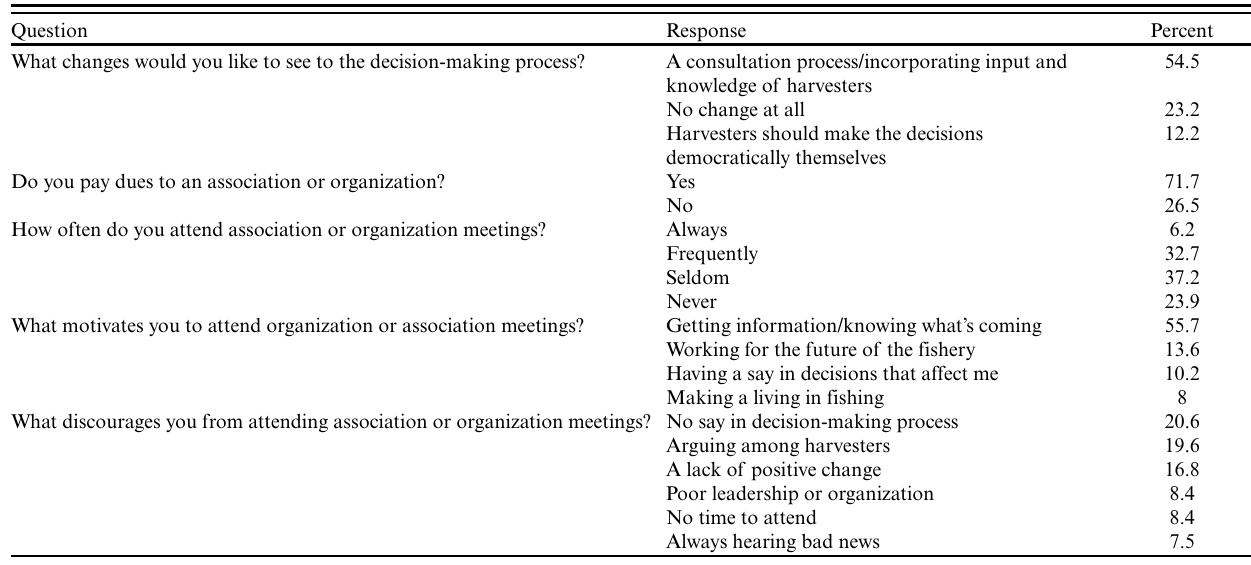
Table 3 . Harvesters’ responses to questions about decision making and